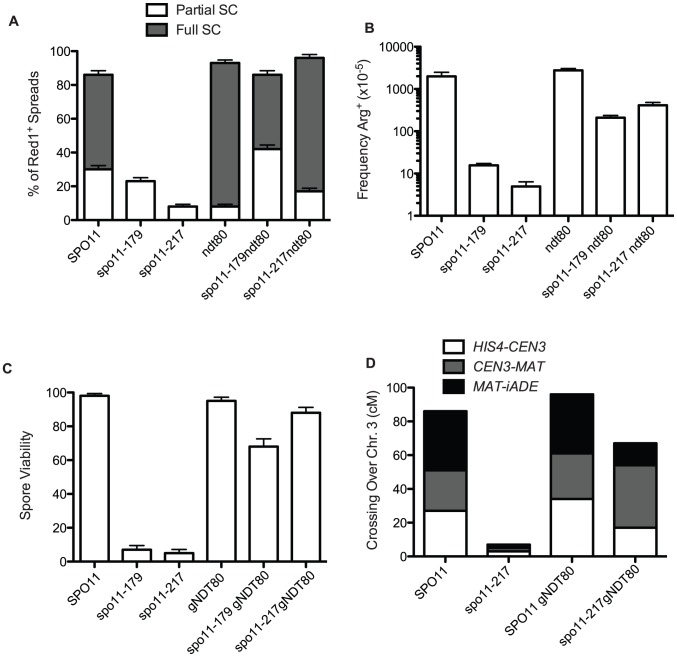
Pachytene arrest rescues spo11 mutants.A. Extent of SC formed in spo11 mutants in NDT80+ and ndt80 backgrounds after 48 hours sporulation at 18°C. White bars are partial SC (i.e., at least two linear tracts of SC, “some SC” in Table S2) and dark bars represent nuclei with most chromatin containing Zip1 in stretches (“Full SC” in Table S2). At least 100 spreads exhibiting Red1 staining were scored for each mutant. B. Arg prototrophs were measured in “return-to-growth” assays from at least 4 cultures (Table S1) and the average is plotted with standard deviations. C and D. gNDT80 strains (pGal-NDT80 – GAL4.ER) were arrested at pachytene for 48 hours and then induced to sporulate by the addition of estrogen. C. Spore viability was scored among 85 tetrads for pGal-NDT80, 172 tetrads for spo11-217 pGal-NDT80 and 25 tetrads for spo11-179 pGal-NDT80. D. At least 100 four-spore-viable tetrads were scored for recombination for three intervals on chromosome 3. Control NDT80+ data was from tetrad dissection and spo11-217 data is from isolated spo13 spores (Table S1, S3).